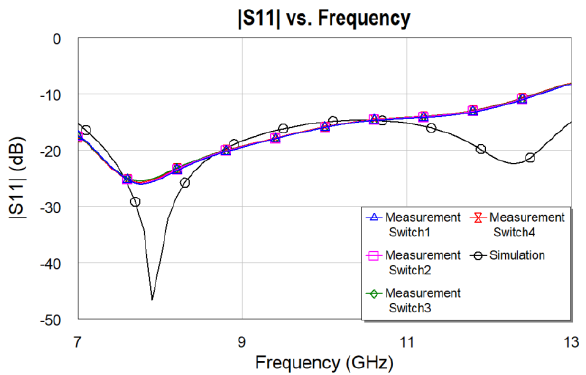
Figure 24: Reflection for the designed switch. Black line simulation. Other lines measurement